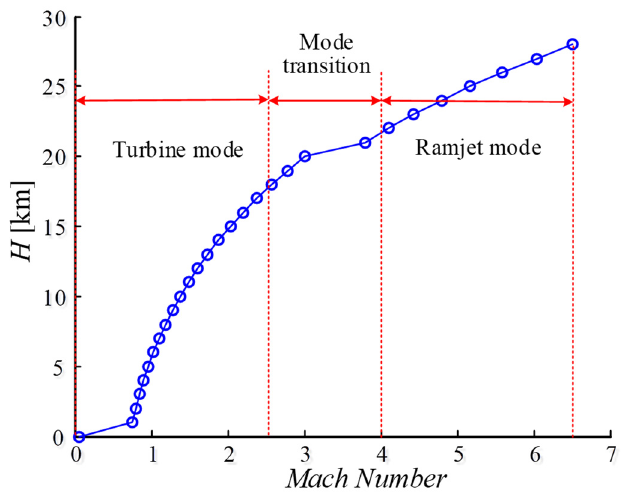
Figure 5. Trajectory of the TBCC vehicle.